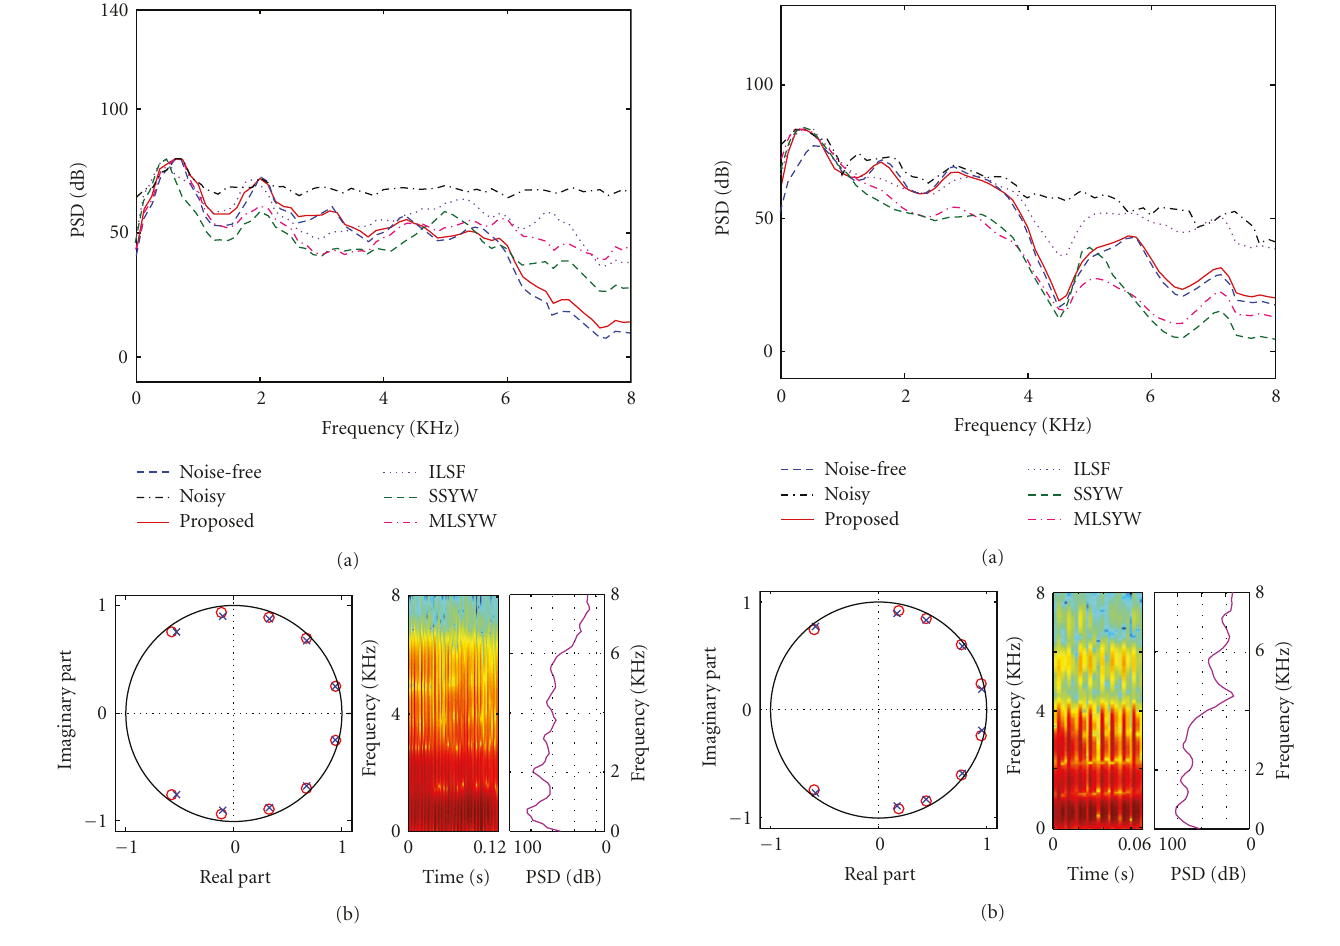
Figure 5: Estimation results for a natural speech phoneme /ε/ in the presence of white noise at SNR = − 5 dB. (a) PSD obtained by using di ff erent methods, (b) Average estimated poles ( × ) obtained from noise-corrupted speech by using the proposed method along with the noise-free estimates ( (cid:9) ) obtained by the MLSYW method, spectrogram of the noise-free speech, and noise-free PSD.